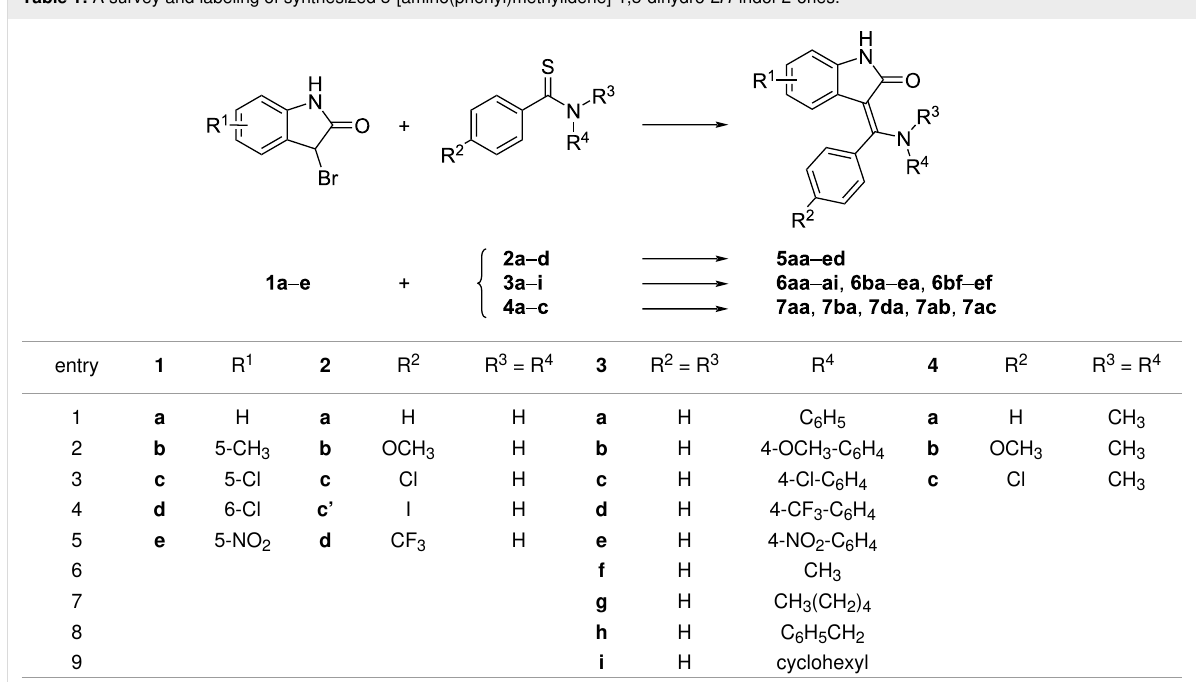
Table 1: A survey and labeling of synthesized 3-[amino(phenyl)methylidene]-1,3-dihydro-2 H -indol-2-ones.